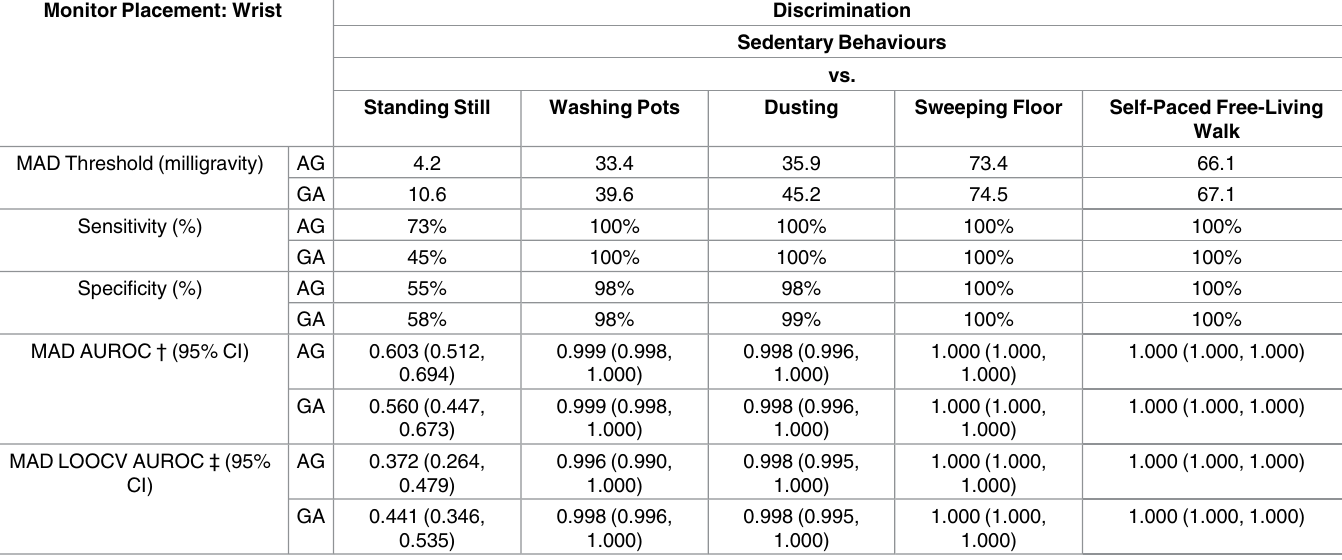
Table 7. Monitor-specific wrist Mean Amplitude Deviation (MAD (measuredin milligravity units)) thresholds to differentiate between sedentary behaviours and light-intensity physical activities. Monitor Placement: